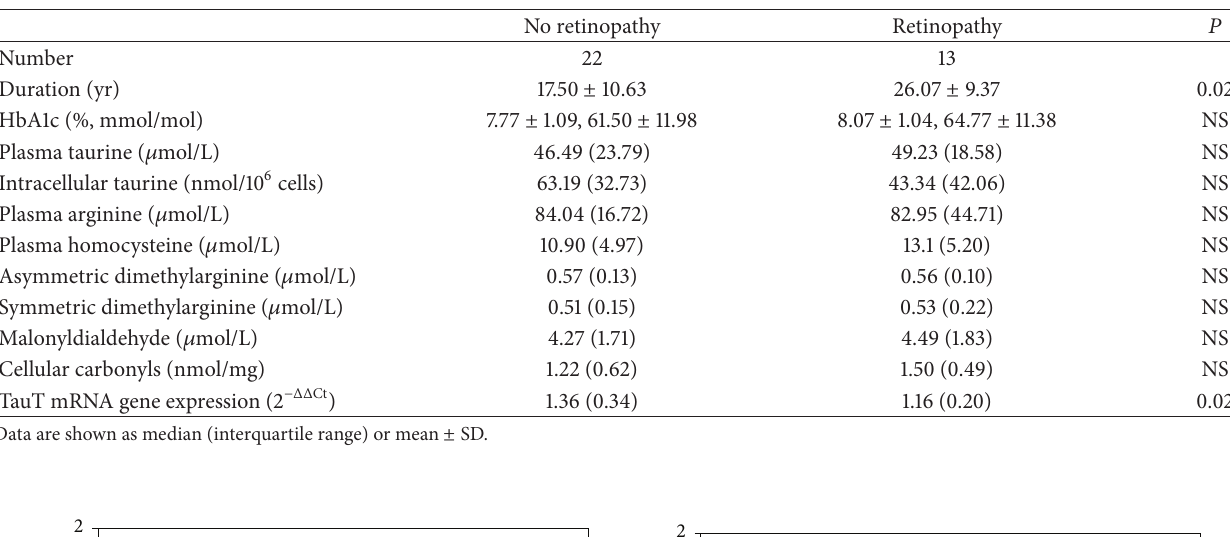
Table 3: TauT mRNA cell expression and plasma markers of oxidative stress or endothelial function in controls and in type 1 diabetic patients with or without retinopathy.